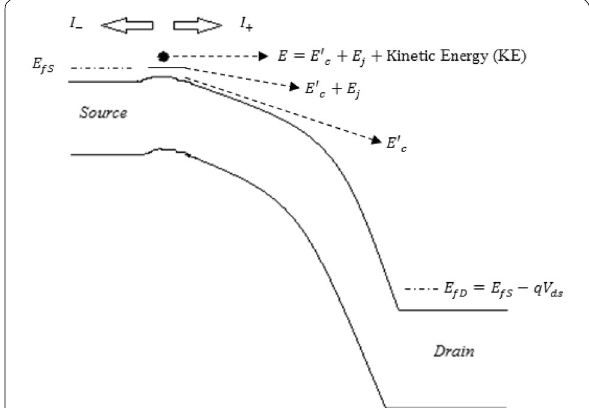
Fig. 2 Schematic of a bulk nanoscale MOSFET band diagram under high-drain bias conditions [12]. For the proposed work of SDG MOSFET, a vertical mirror image of the above band diagram is to be considered due to bottom gate